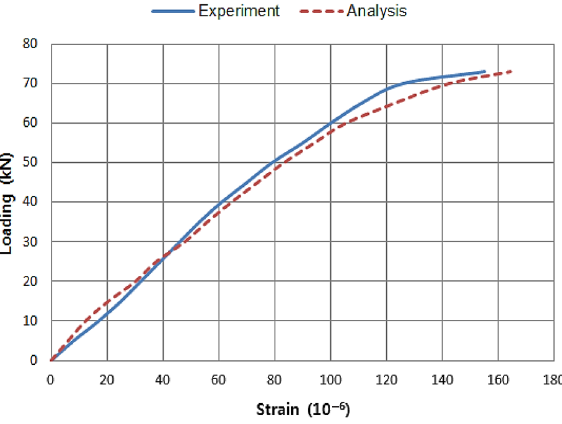
Fig. 21. Load-stain curves of